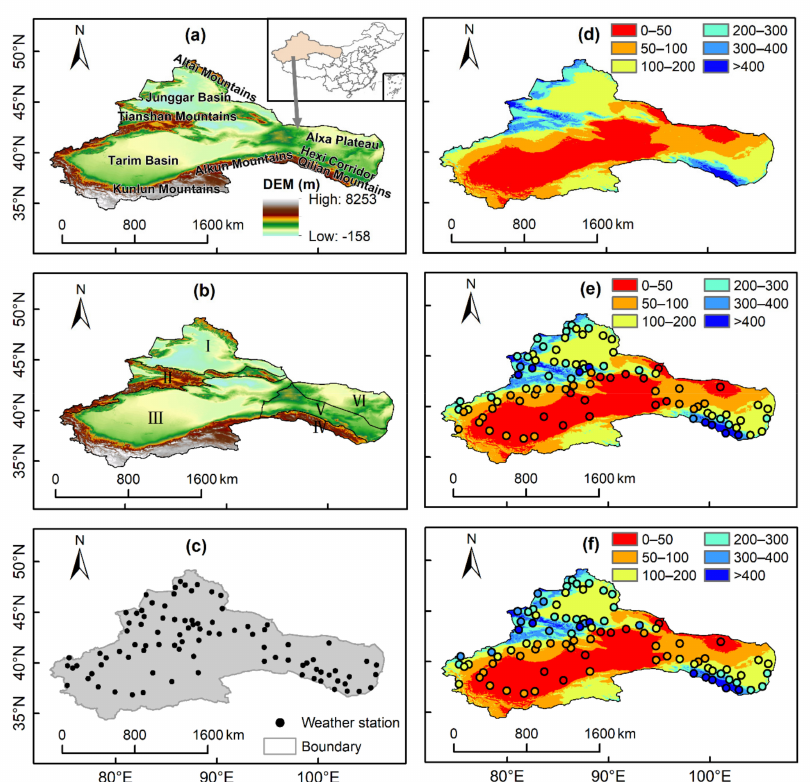
Figure 1. ( a ) DEM and the topography of the study area, ( b ) the division of six subregions, ( c ) the spatial distribution of 91 weather stations, ( d ) the spatial distribution of mean annual precipitation based on the gauge data from 1970 to 2000 (calculated from WorldClim version 2.1 monthly climate data for precipitation; data can be obtained at https://www.worldclim.org/data/worldclim21.html accessed on 3 March 2022), ( e ) the spatial distribution of mean annual precipitation based on the gauge data without bias correction from 2003 to 2015 (the values are displayed in the points of 91 weather stations; the same is for Figure 1f), and ( f ) the spatial distribution of mean annual precipitation based on the bias-corrected gauge data from 2003 to 2015. All of the maps in Figures 1–4 were created by ArcGIS 10.2 software.